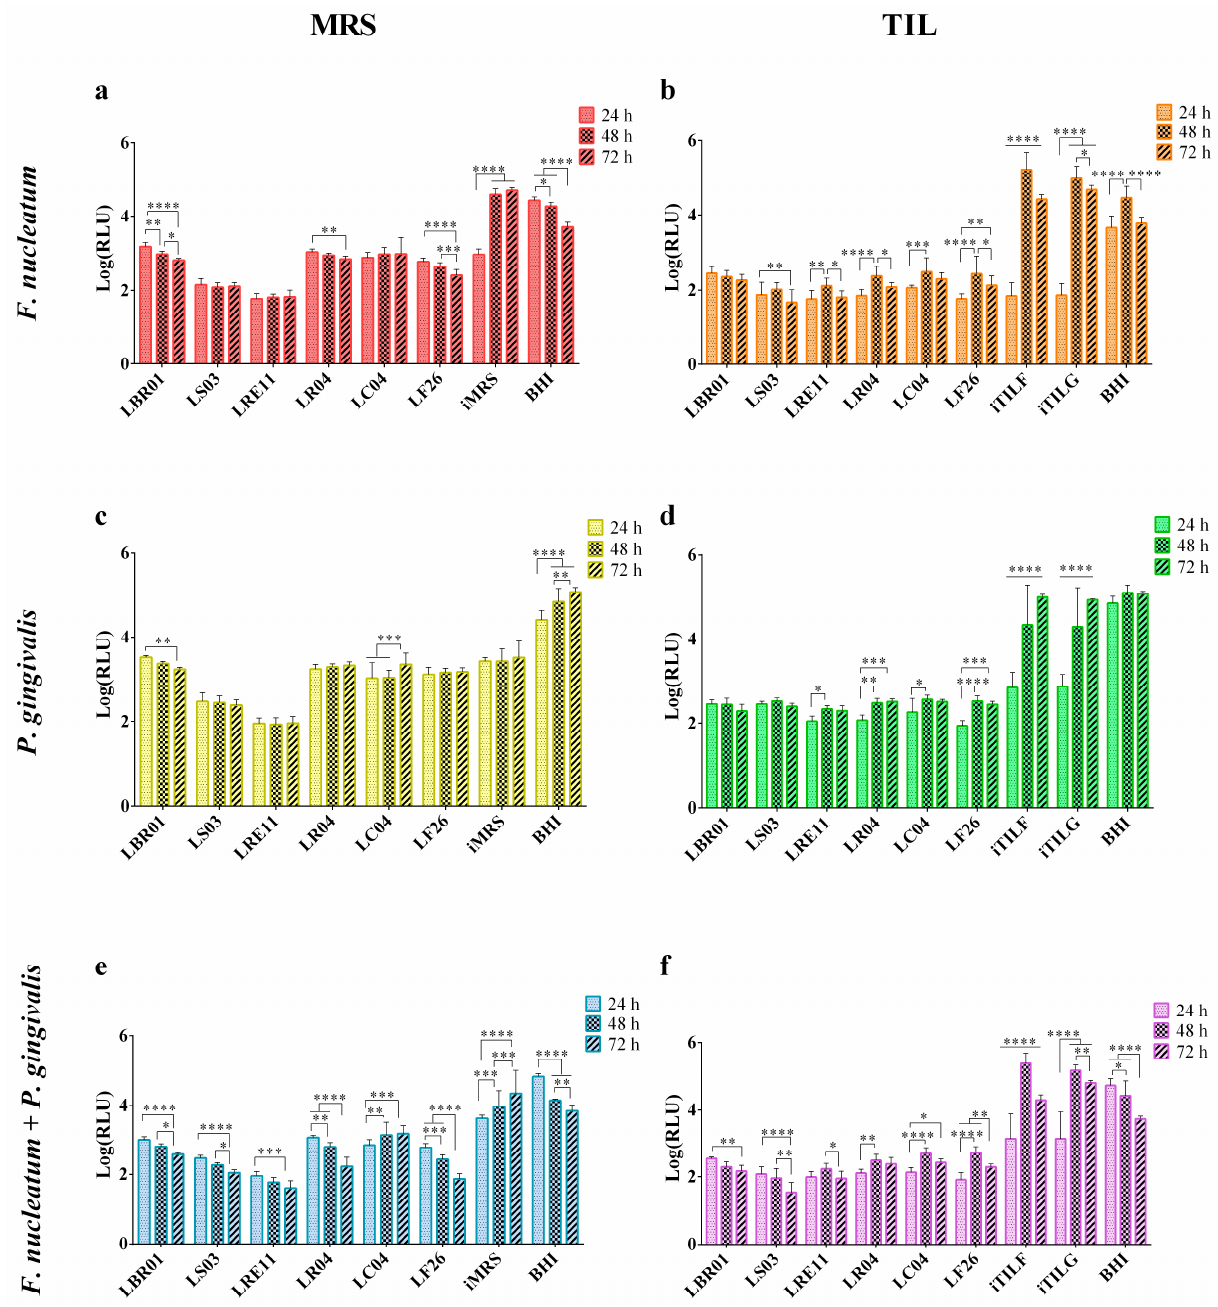
Figure 2. Viability assay. Pathogen viability was determined after 24, 48, and 72 h of probiotic CFS treatment in MRS: ( a ) F. nucleatum , ( c ) P. gingivalis , ( e ) F. nucleatum + P. gingivalis ; and in TIL: ( b ) F. nucleatum , ( d ) P. gingivalis , ( f ) F. nucleatum + P. gingivalis . Data are represented as the Log(mean) of three independent experiments ± SD. * p < 0.05; ** p < 0.01; *** p < 0.001; **** p < 0.0001. Log(RLU) = Logarithm10 (relative luminescence unit); CFS = cell-free supernatant.